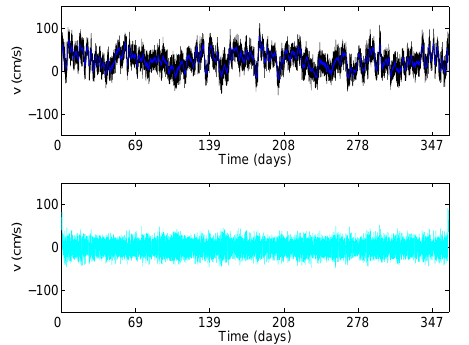
Fig. 2. High frequency data (cyan), tidal data (red) and surge data (green) are shown for v component at location FB, 524m